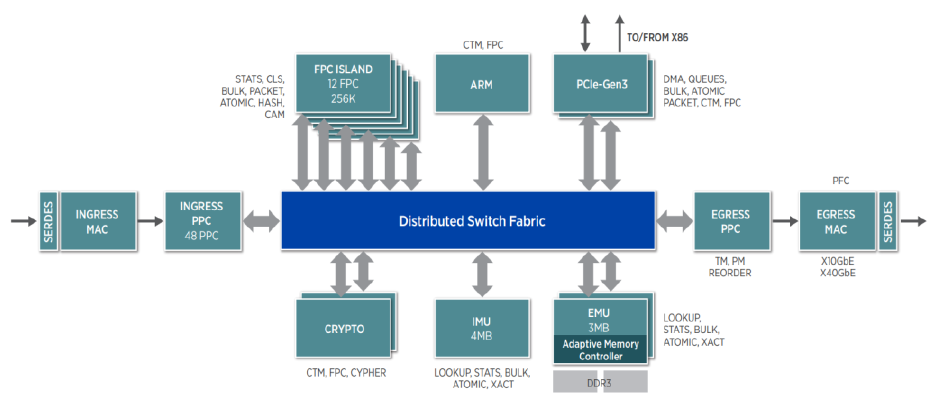
Figure 5. Netronome 4000 Micro architecture.